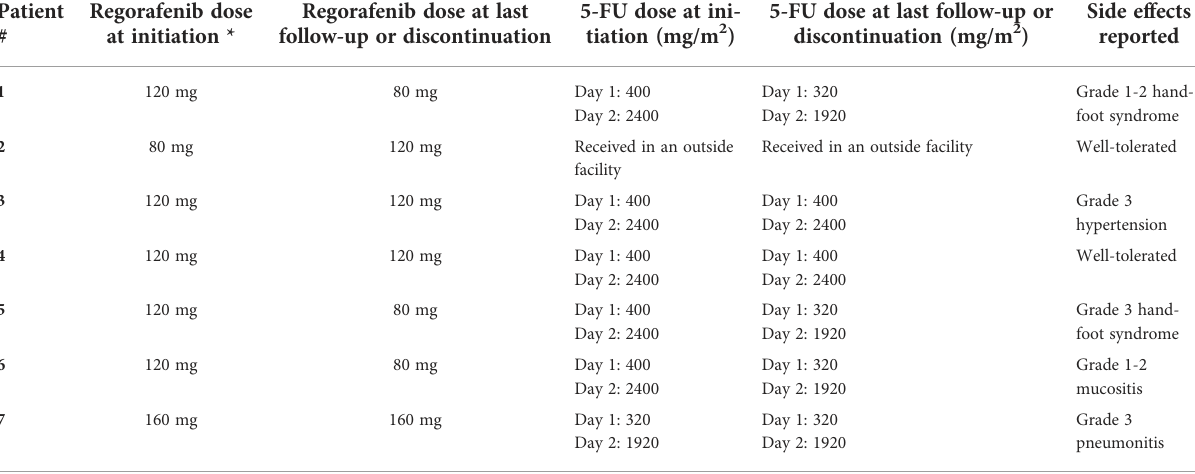
TABLE 3 Dosing and reported side effects for patients receiving regorafenib and 5-FU, *All patients were started at a dose of 40-80 mg for a week and then increased to the dose listed. Patient